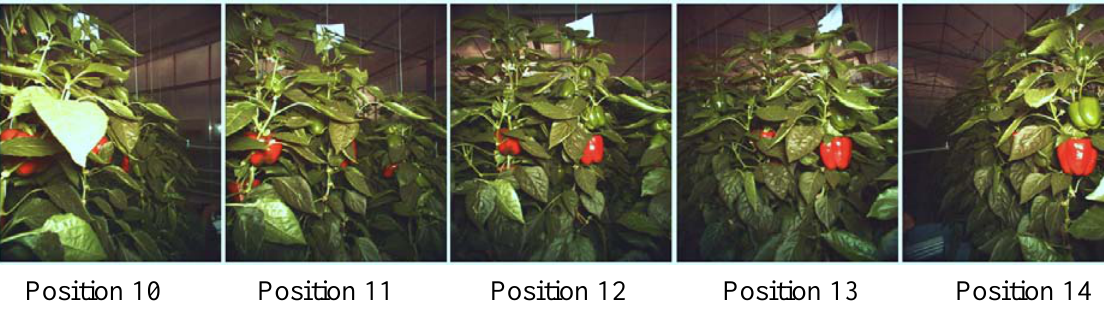
Position 10 Position 11 Position 12 Position 13 Position 14 Figure 5. ( a ) Average FD and standard deviation (SD) for different azimuth angles, for cultivar Helsinki (first session); ( b ) Average FD and standard deviation (SD) for different azimuth angles, cultivar Nagano (third